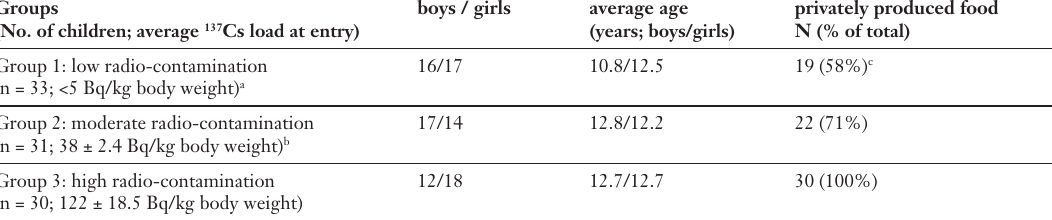
Table 1 Demographic data and percentage of children consuming privately produced